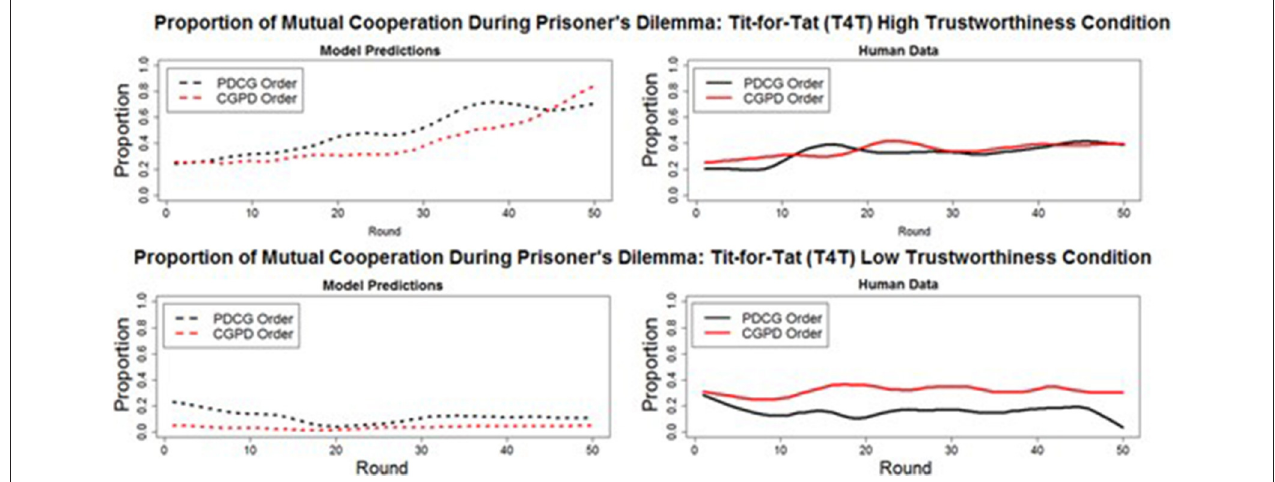
FIGURE 8 | The round-by-round proportion of mutual cooperation during Prisoner’s Dilemma in both the model predictions (dashed lines) and human data (solid lines), when played before (PDCG order: black line) and after (CGPD Order: red line) the Chicken Game. All of the overall round-by-round proportions were smoothed by using the loess function in R (smoothing parameter of 0.2), to remove some of the round-by-round variability.